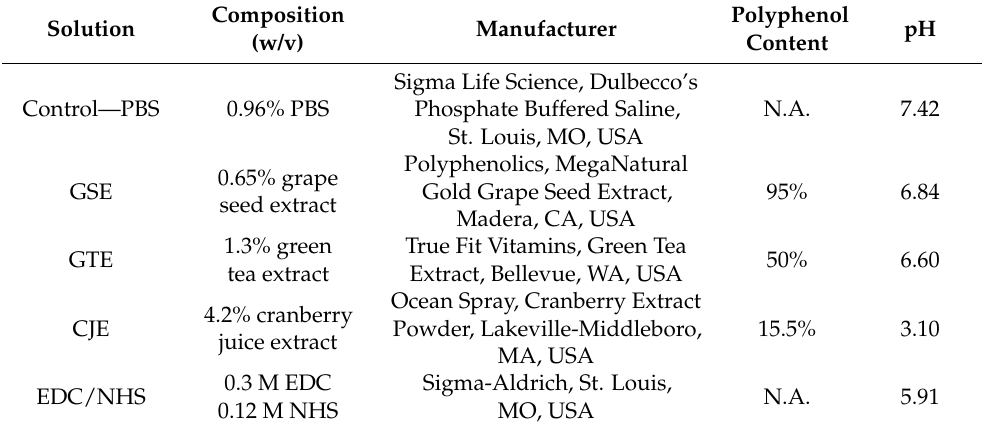
Table 1. Treatment solutions and their composition, manufacturer, and polyphenol